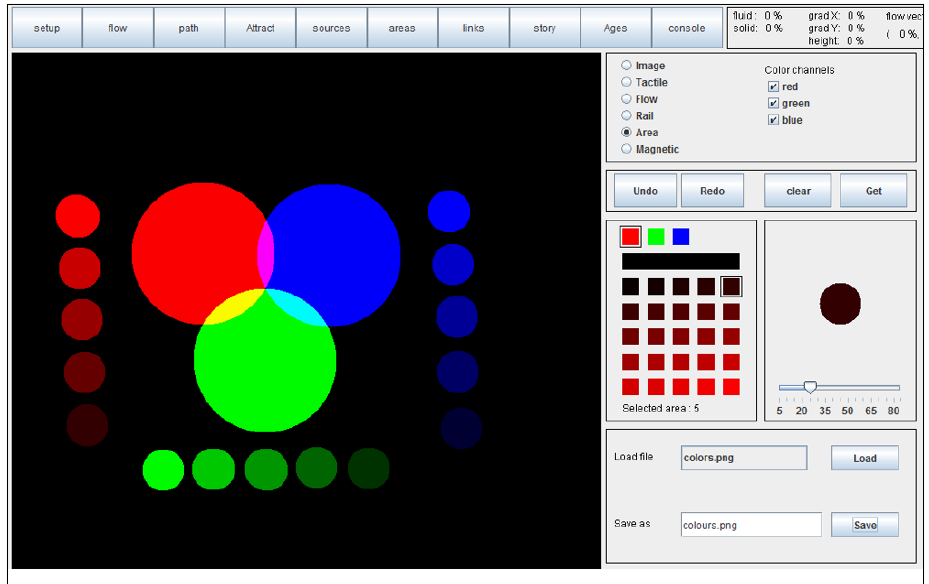
Figure 6. Examples of color-coded representations of the haptic effects used to simulate image properties. Red channel corresponds to fluid friction, blue channel to solid friction, and green channel to the elevation of the shape.